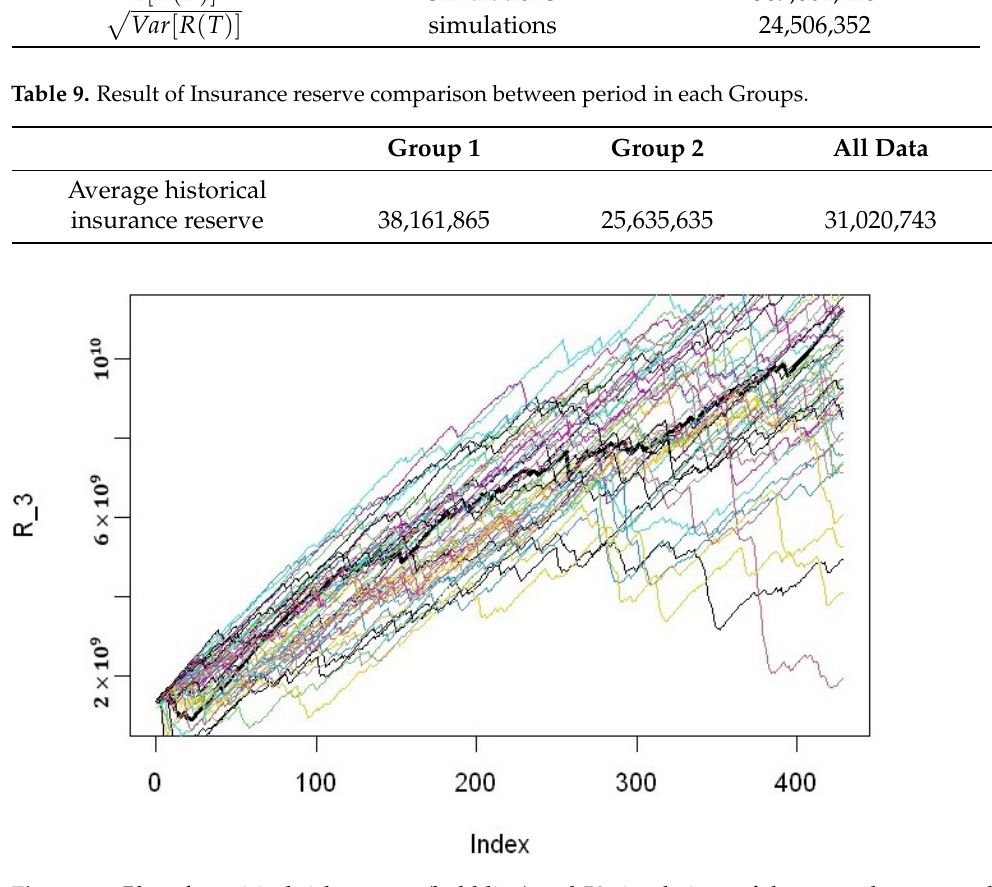
Figure 17. Plot of empirical risk process (bold line) and 50 simulations of the general compound Hawkes process for all